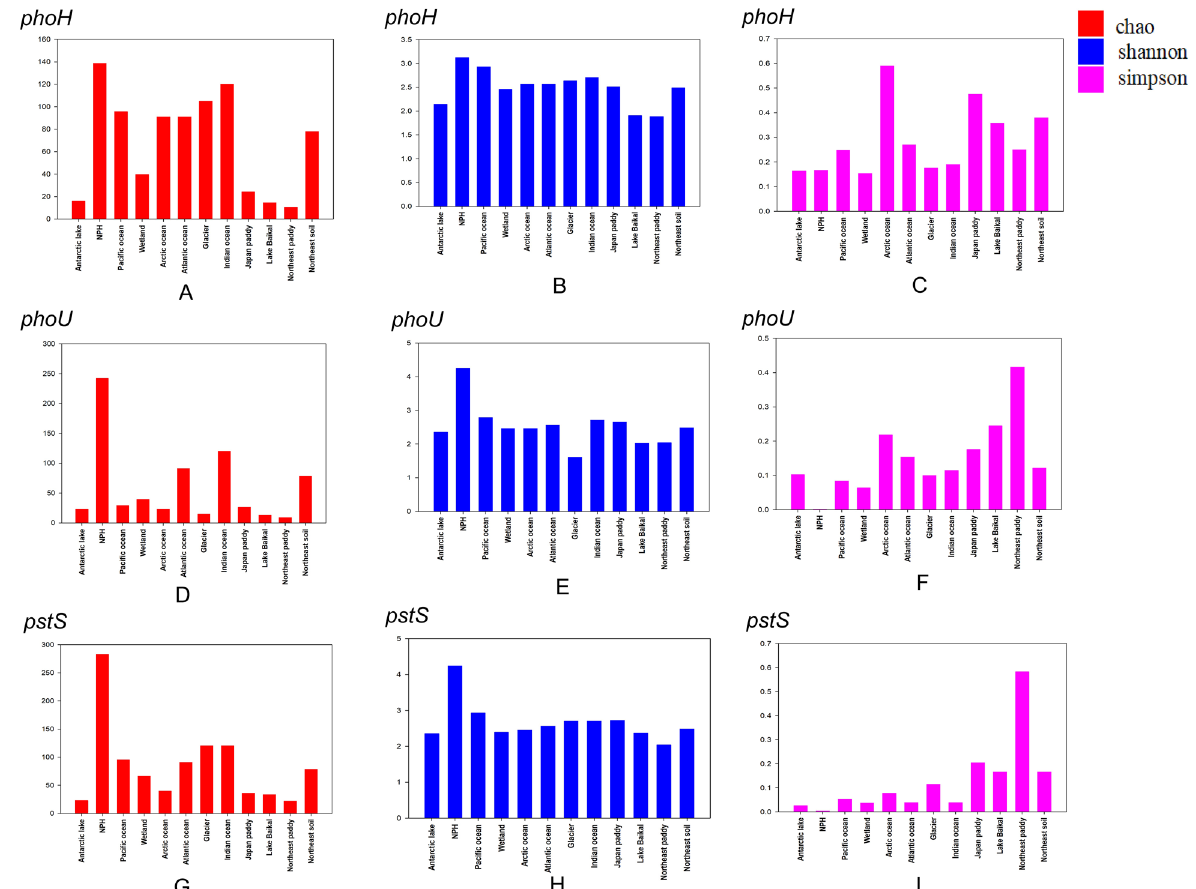
Figure 4. Plots of genetic diversity indices analysis of phosphorus metabolism AMGs in different habitats, different colors represent different genetic diversity indices. ( A , D , G ) Represent respectively the Chao values of phoH , phoU , and pstS genes in different habitats. ( B , E , H ) Represent respectively the Shannon values of phoH , phoU , and pstS genes in different habitats. ( C , F , I ) Represent respectively the Simpson values of phoH , phoU , and pstS genes in different